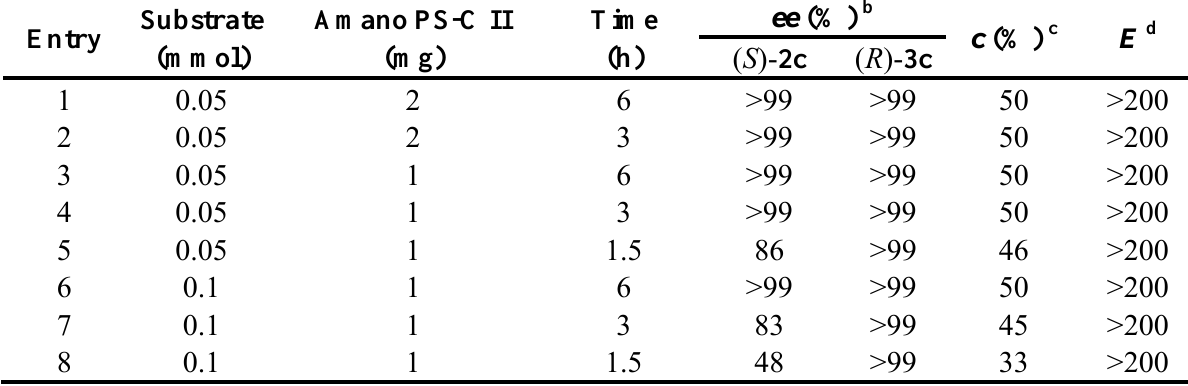
Table 2. Evaluation of reaction time and enzyme/substrate ratio for kinetic resolution of ( RS )- 2c a